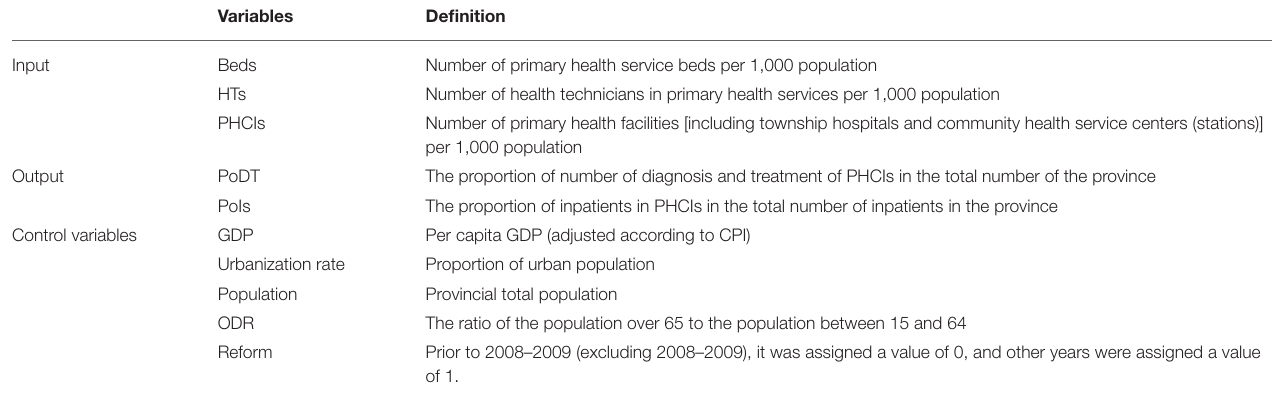
TABLE 1 | Definition of input–output and control